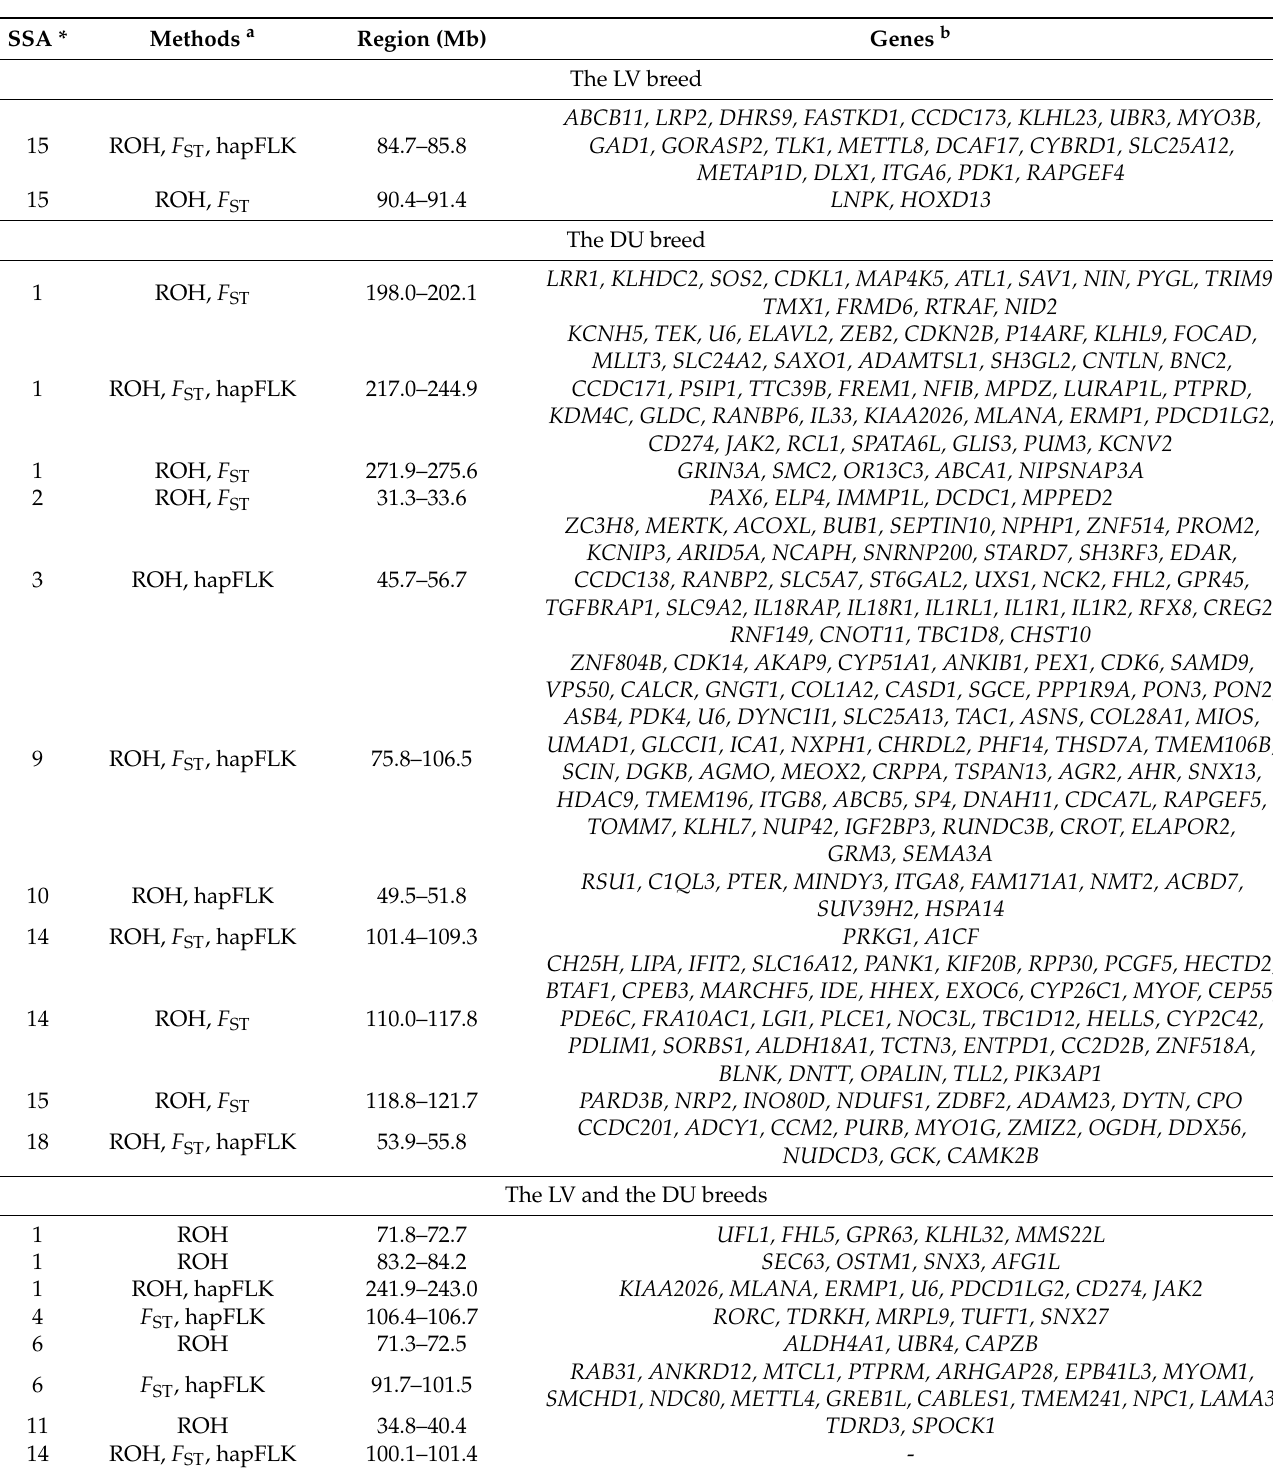
Table 4. Genes within the overlapped genomic regions affected by putative